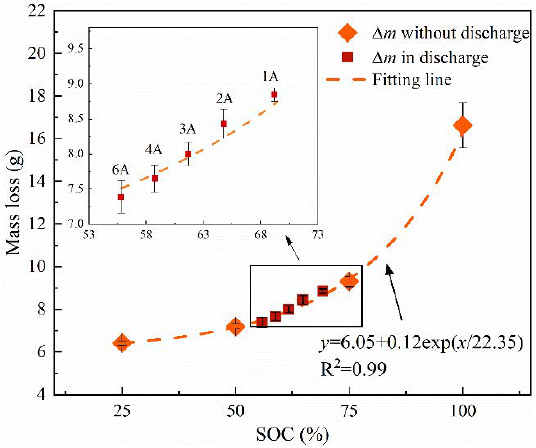
Figure 5. Mass loss during thermal runaway process as a function of SOC.